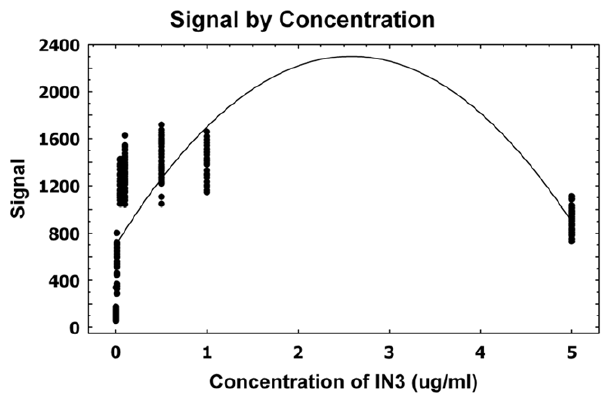
Figure 1. A scatterplot with regression fit for the GnRHR pharmacoperone assay. A linear regression analysis was attempted to evaluate the linearity/association of the dose-response of pharma- coperone and concentrations of dose by estimating a polynomial function.